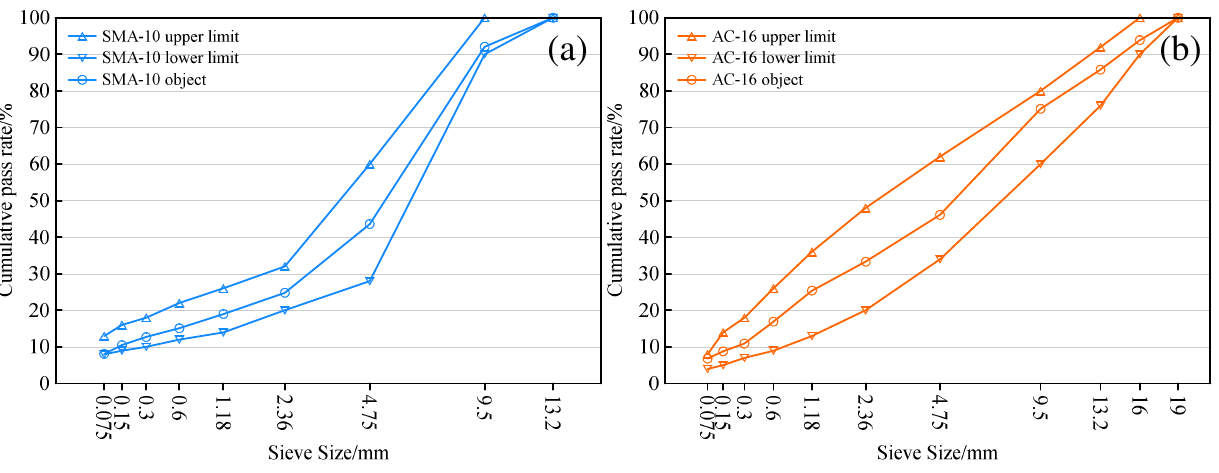
Figure 1. Gradation curves of SMA-10 and AC-16. ( a ) Gradation curve of SMA-10; ( b ) Gradation curve of AC-16.